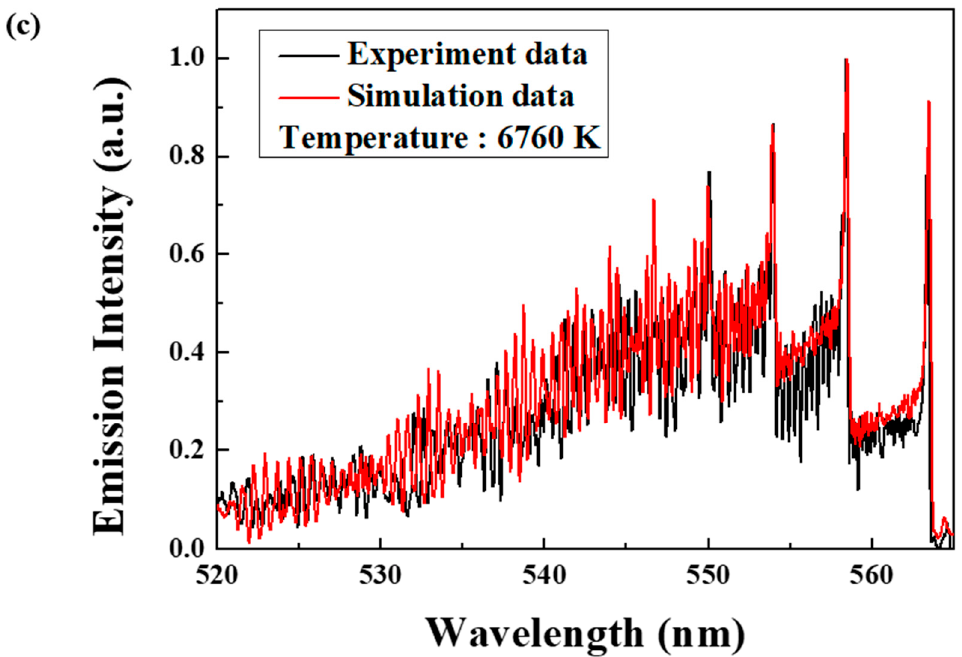
Figure 2. Axial position–dependent emission spectra of ( a ) species and (b) atomic oxygen generated within the CO 2 microwave plasma torch. ( c ) Calculated and measured emission spectra for the C 2 Swan band transition in the CO 2 microwave plasma torch.